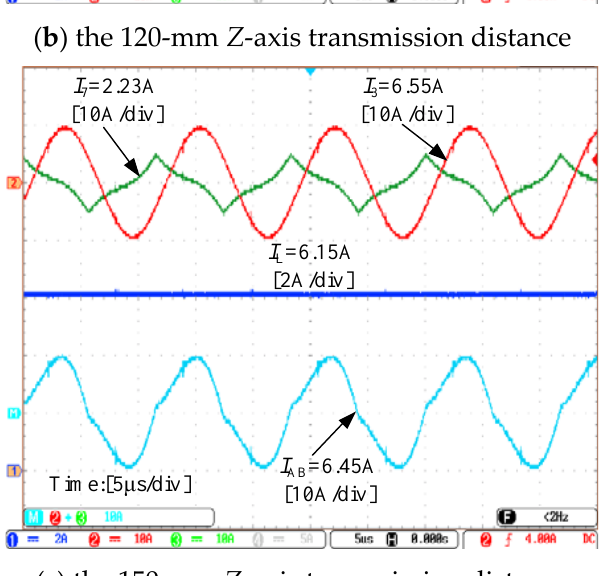
Figure 15. Experimental waveforms of I 3 and I 7 with R L = 17 Ω .